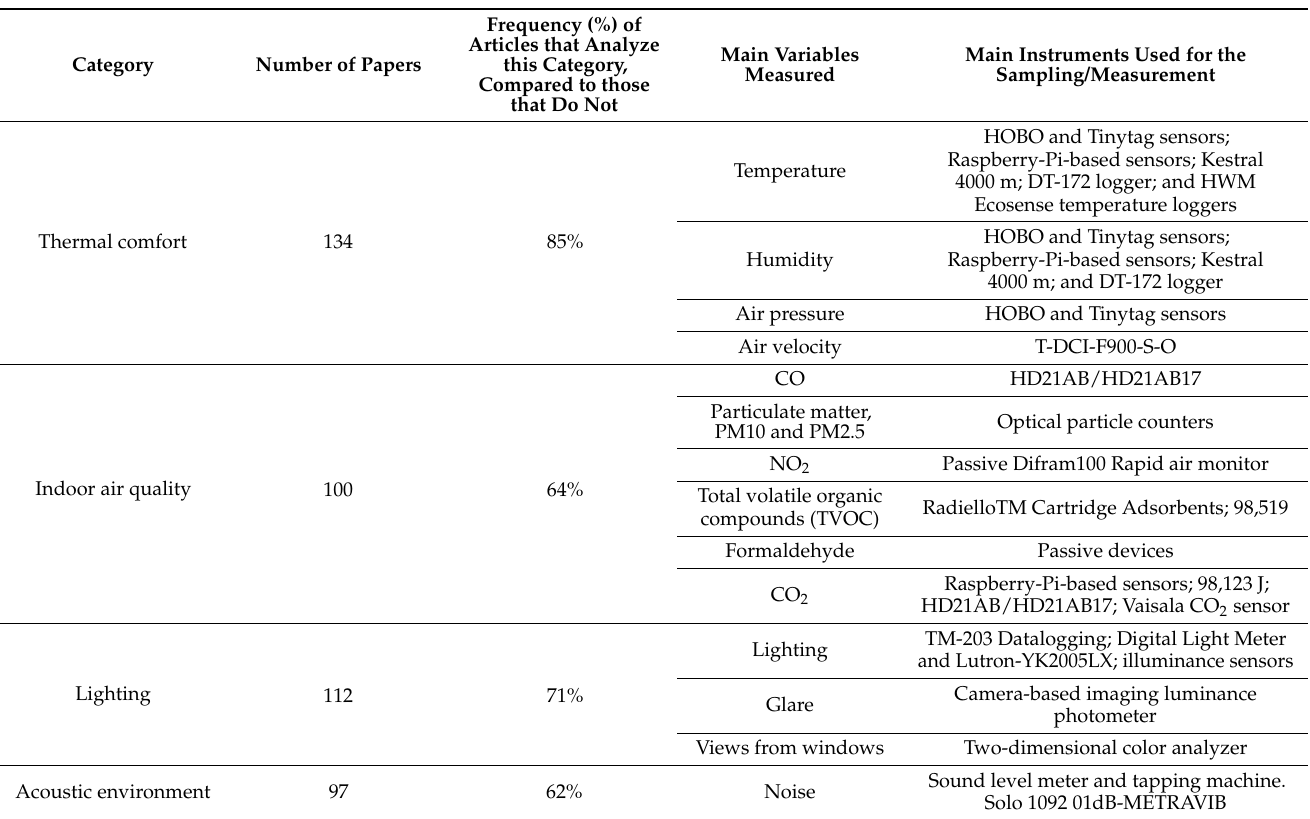
Table 5. IEQ categories